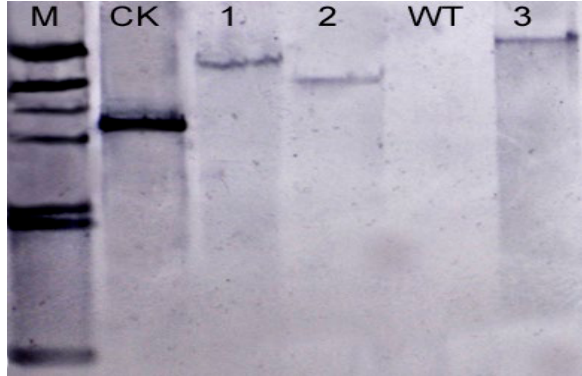
Figure 4. Genomic Southern blot analysis of virulent Lasio- diplodia theobromae mutants with a probe (parts of hygro- mycin B). Legend: M, marker, λDNA digested with Hin- dIII; CK, positive control, vector; 1, 2, and 3, mutants that exhibited a stronger virulence compared with the wild- type strain; WT, wild-type JZB 0300251 strain.